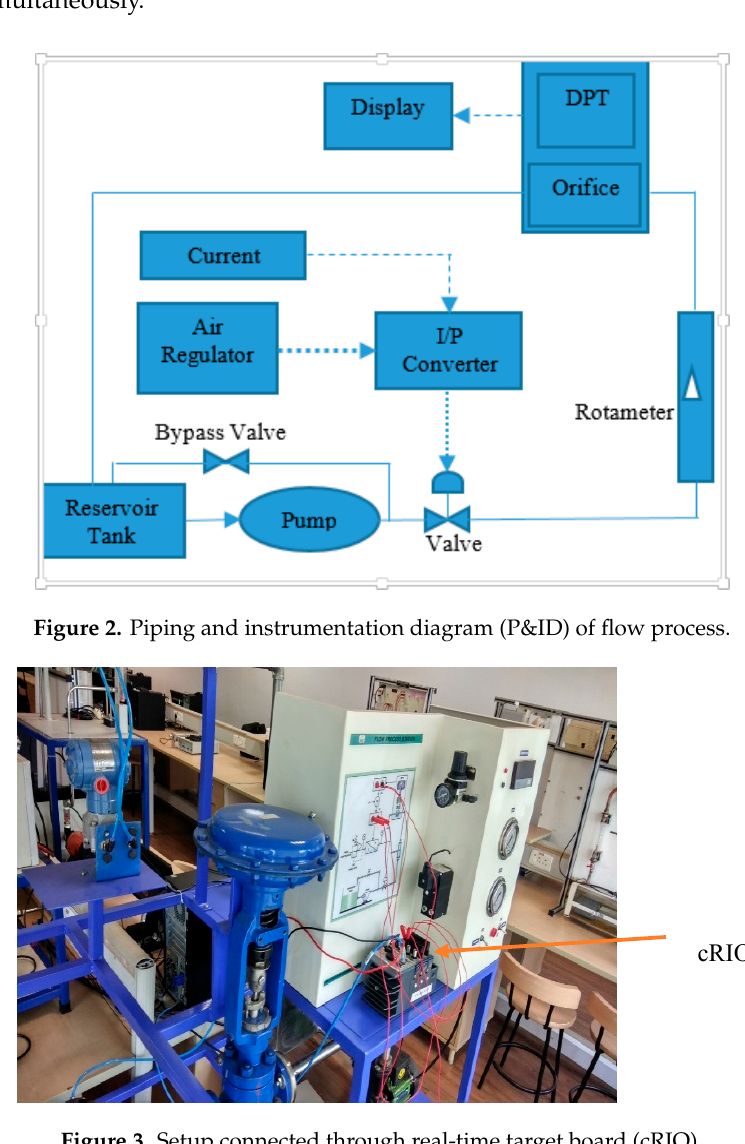
Figure 3. Setup connected through real-time target board (cRIO).